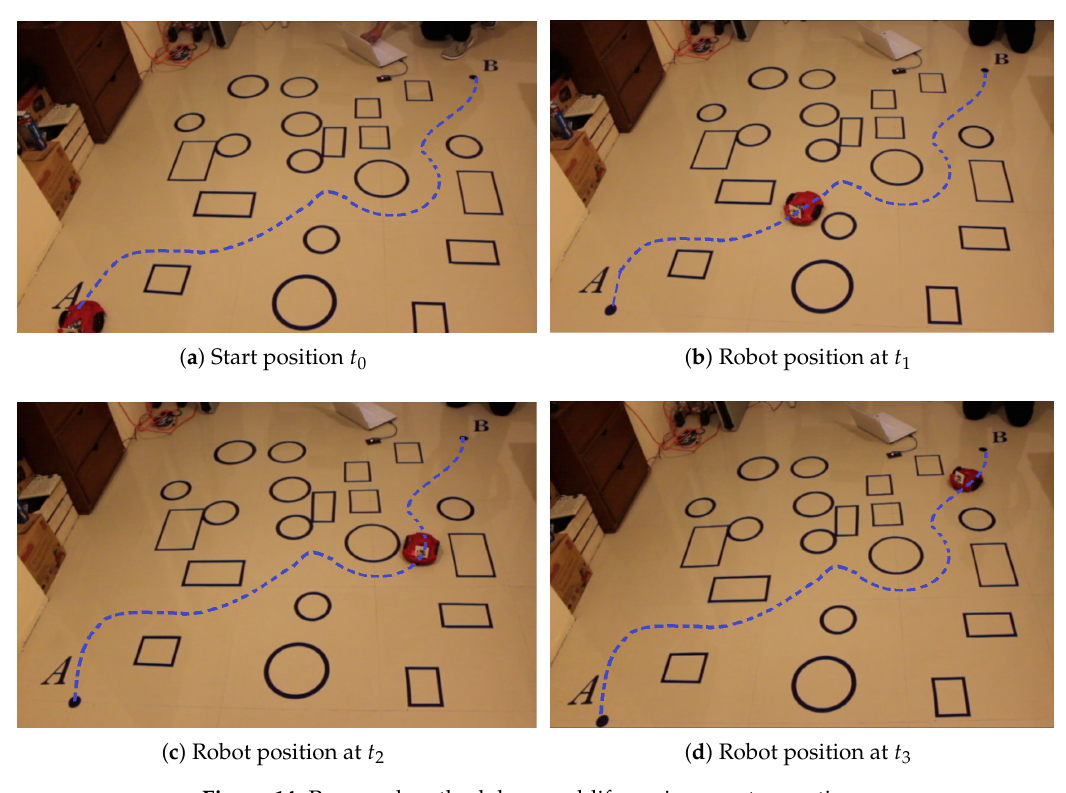
Figure 14. Proposed methodology real-life environment